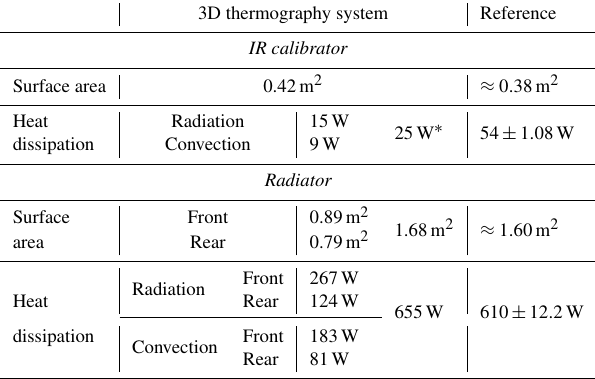
Table 3. Calculated surface area and heat dissipation of the infrared calibrator and the radiator. As a reference the area (measured with a folding rule) and the electrical power consumption (measured by a wattmeter) are given. ∗ The overall heat dissipation is the sum of radiation and convection, but the values have more decimal places and are rounded in the